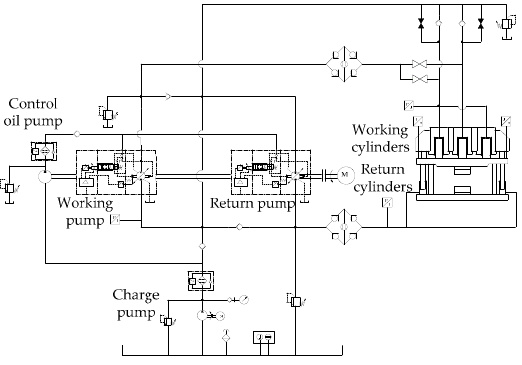
Figure 12. The test-bed hydraulic system scheme of pump-controlled system.